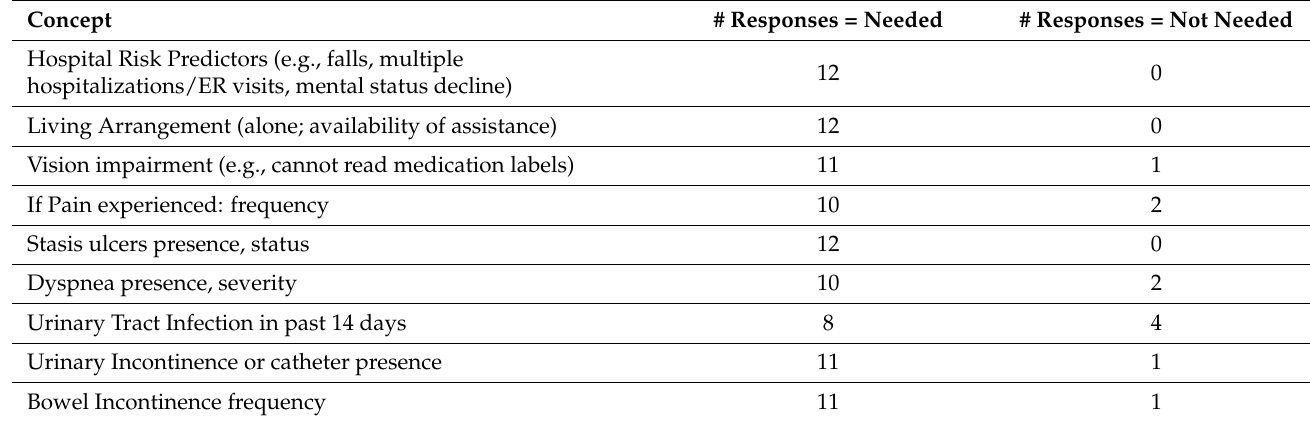
Table 4. Survey Responses indicating OASIS Items needed for Transition of Care visit (N =